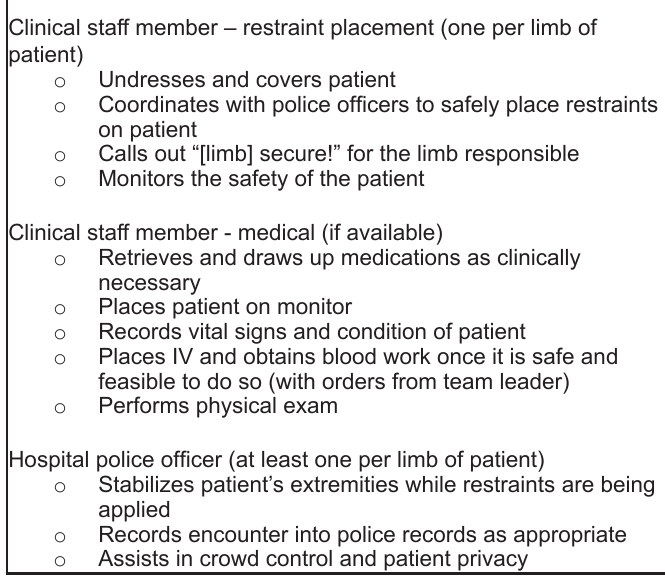
Figure 1. Agitated patient care team: roles and